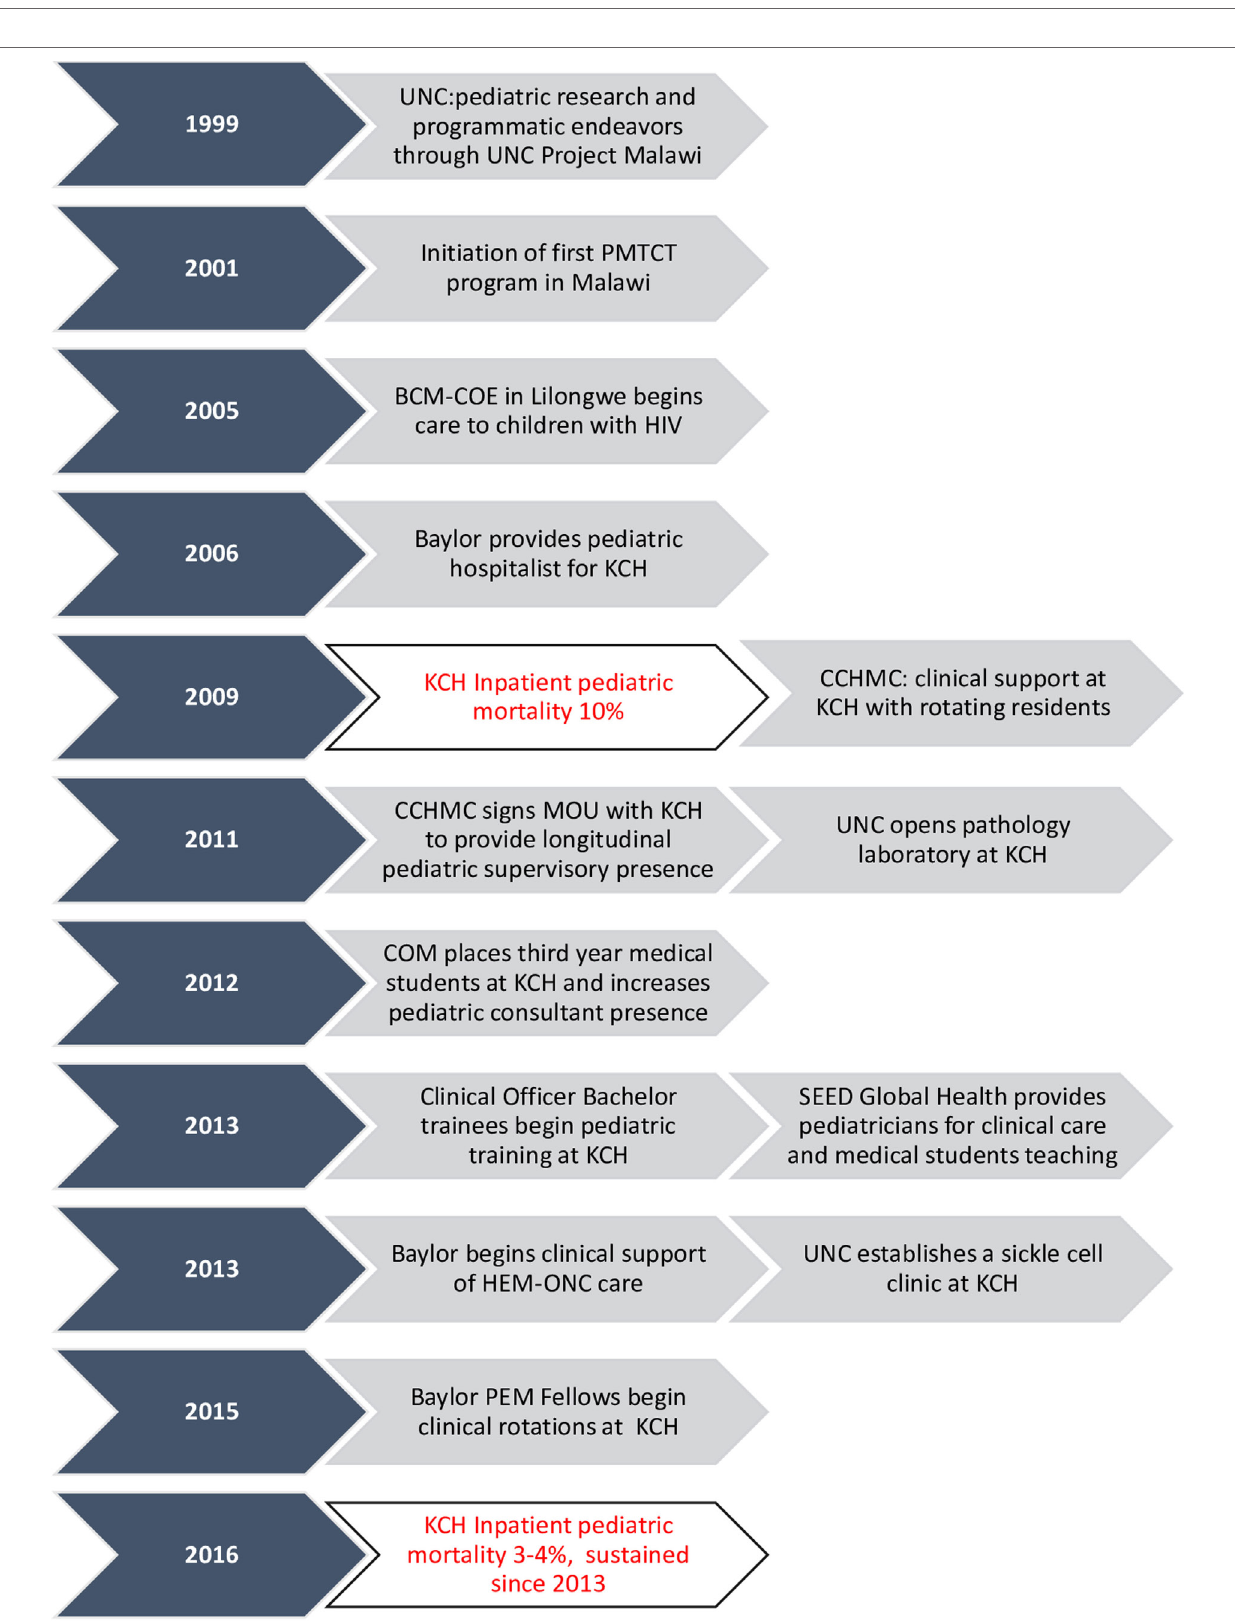
FiGuRe 1 | Timeline of institutional activities at Kamuzu Central Hospital